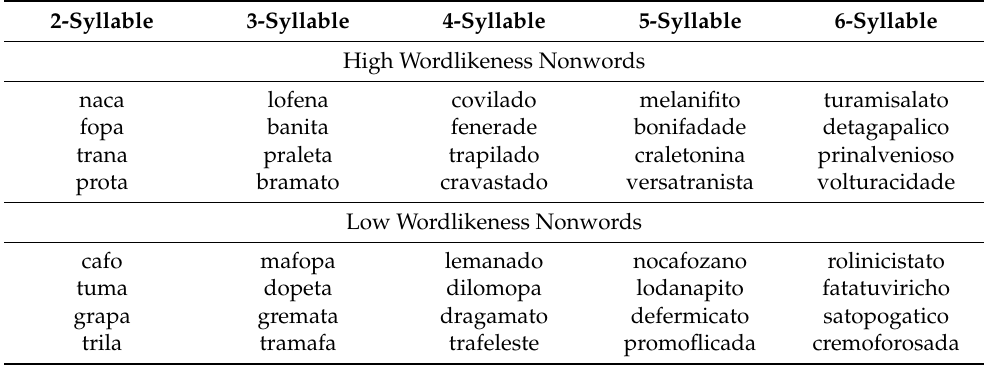
Table 3. The nonwords for the European Portuguese version of the nonword repetition task (NRT- EPort) by syllable length and